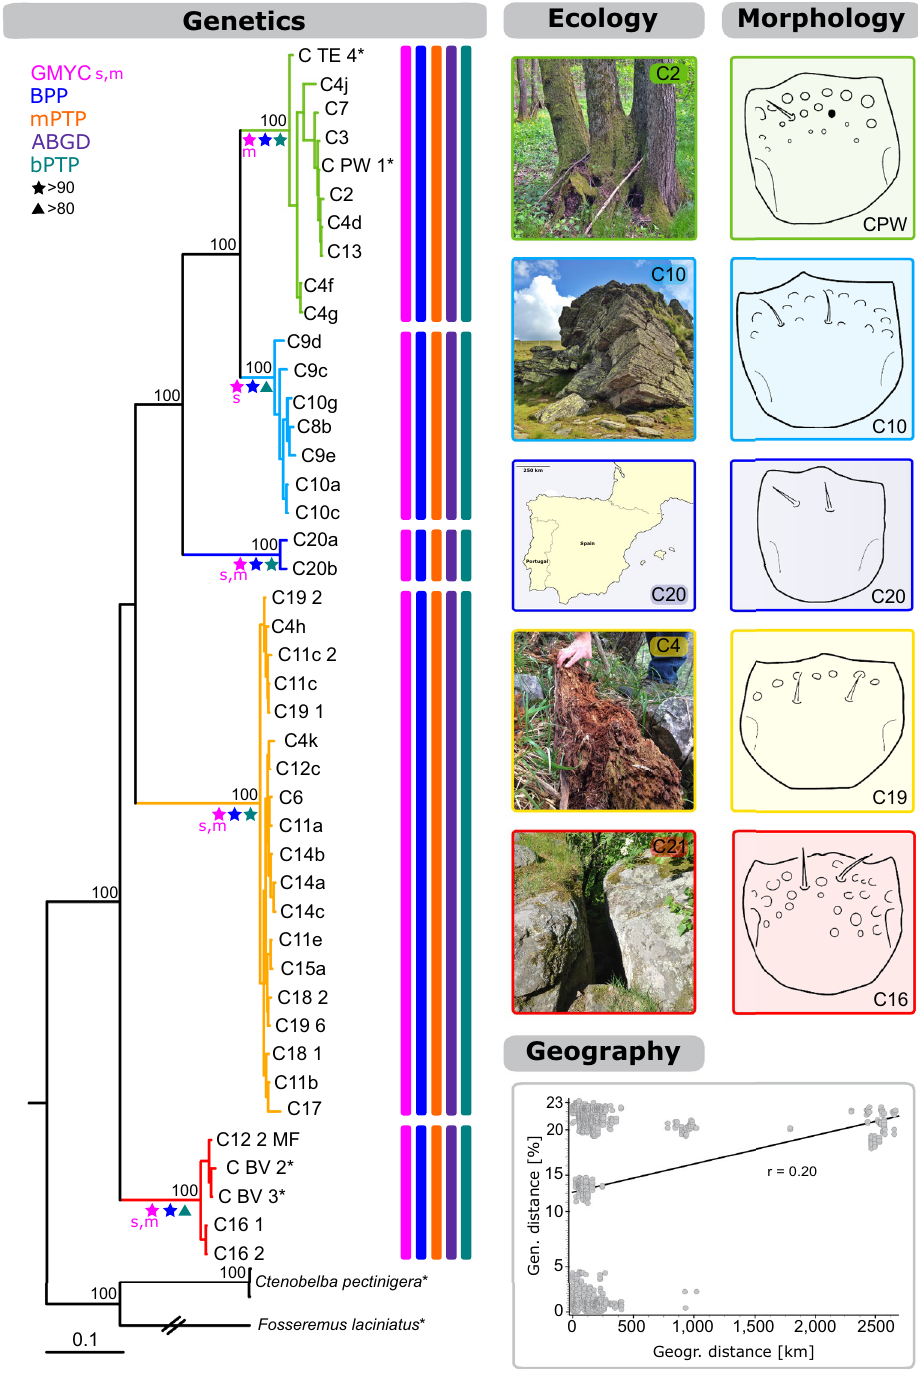
Figure 1. Bayesian inference tree based on the concatenated dataset (COI and EF-1α, N = 46) with the summary of species delimitation analyses, ecological characteristics, geographic and genetic correlation, and morphological differences for Caleremaeus specimens. Posterior probabilities (> 80) for main splits are indicated by numbers near the nodes. An asterisk marks sequences obtained from GenBank (*Lienhard et al . 39 ). Vertical bars at terminal branches specify delimited species obtained from five different approaches. Yule support values of the GMYC analysis (m = multiple, s = single), Bayesian support values (bPTP), and posterior probabilities (BPP) > 80 are indicated by colored stars and triangles. High values indicate all descendants from this node are more likely to be from one species. Ecology: Pictures display examples of habitats specimens comprising different clades were found in. For the Spain clade no picture was available, substitutionally an image showing the sampling location is given. Morphology: Drawings show ventral mouthparts (menta) with characteristic arrays of foveae. Geography: Result of Mantel test of isolation by distance for Caleremaeus specimens based on the COI dataset showing the correlation of genetic (given in %, N = 71) and geographical distances (km). Correlation of genetic and geographical distances: r = 0.20. The map of the Iberian Peninsula in this figure was created with CorelDraw Graphic suite X7 (https:// www. corel draw.